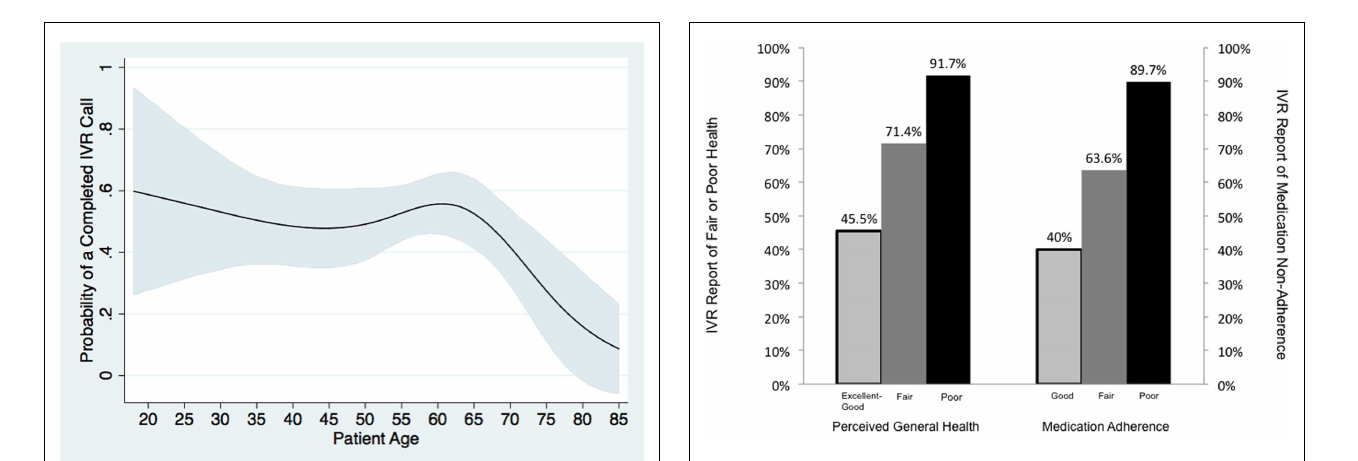
FIGURE 2 |The proportion of patients who reported (left) fair or poor general health and (right) medication adherence problems at least once via IVR, within groups defined by that patient’s baseline survey reports ( X axis) . Baseline medication adherence was measured using the Morisky adherence scale, with scores collapsed into groups as follows: “Good” = 0, “Fair” = 1–2, and “Poor” = 3–8.